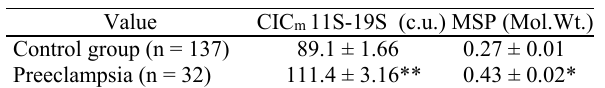
The level of circulating immune complexes and